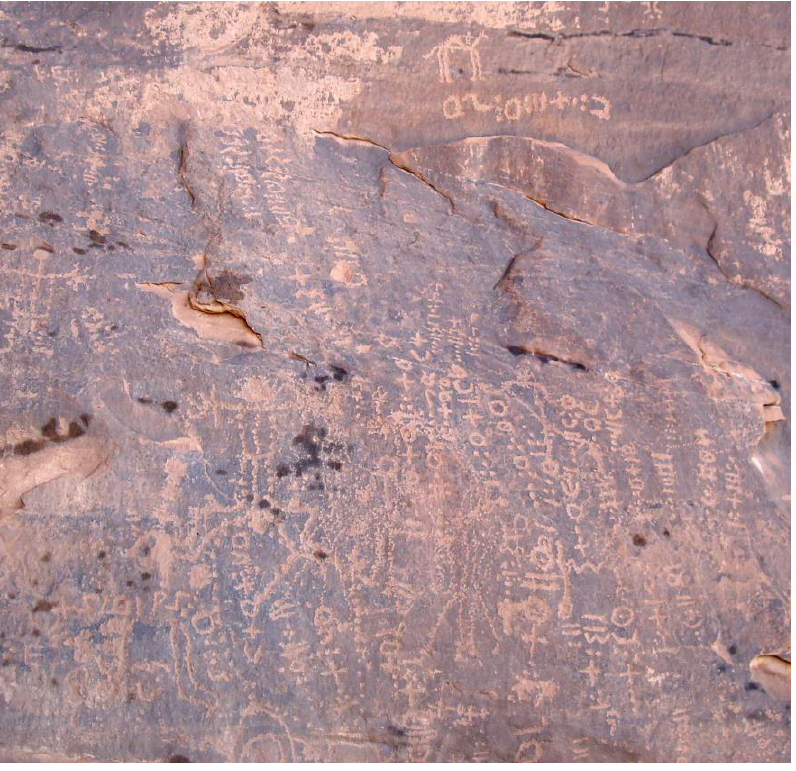
Figure 9. Panel with Tifinagh engravings, from Ti-n-Lalan site (Wadi